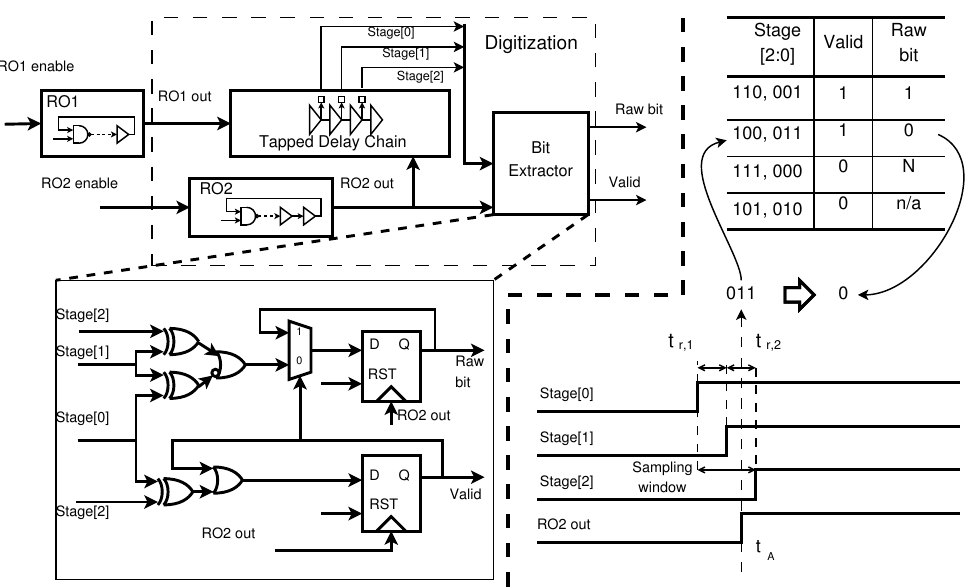
Figure 3: The architecture and operation principle of the digital noise